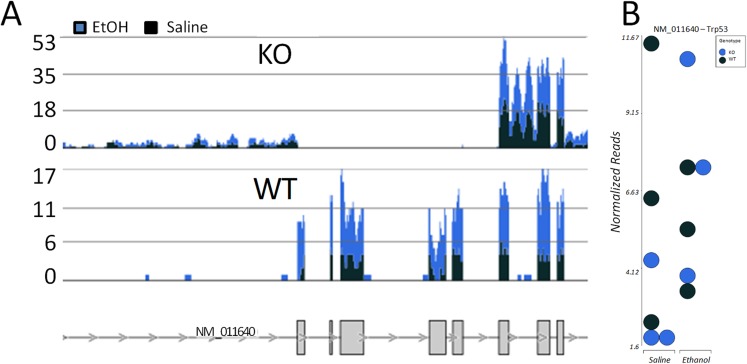
Visualization of p53 expression from the whole somatosensory cortex RNA-Seq data.A, Alignment of RNA-Seq reads spanning the p53 gene, with exon structure shown in gray below. At this magnification, only 8 of the exons can be distinguished (some boxes contain > 1). Note the absence of aligned reads in the p53 KO mice near the 5’ half of the gene, but normal or increased levels of RNA-Seq alignments in the 3’ half of the gene. B, plots of the mean normalized expression level across the entire p53 gene locus for the WT and p53 KO mouse. After ethanol exposure, the levels of the residual p53 gene show evidence of an attempt to increase expression.